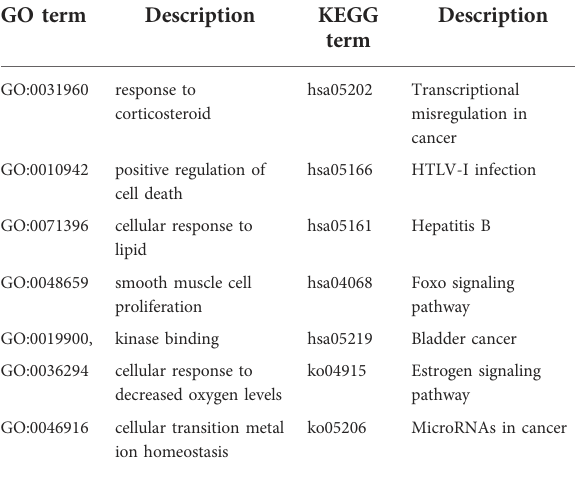
TABLE 2 The top 20 gene ontology and the top 20 KEGG pathway that CDKN1A was